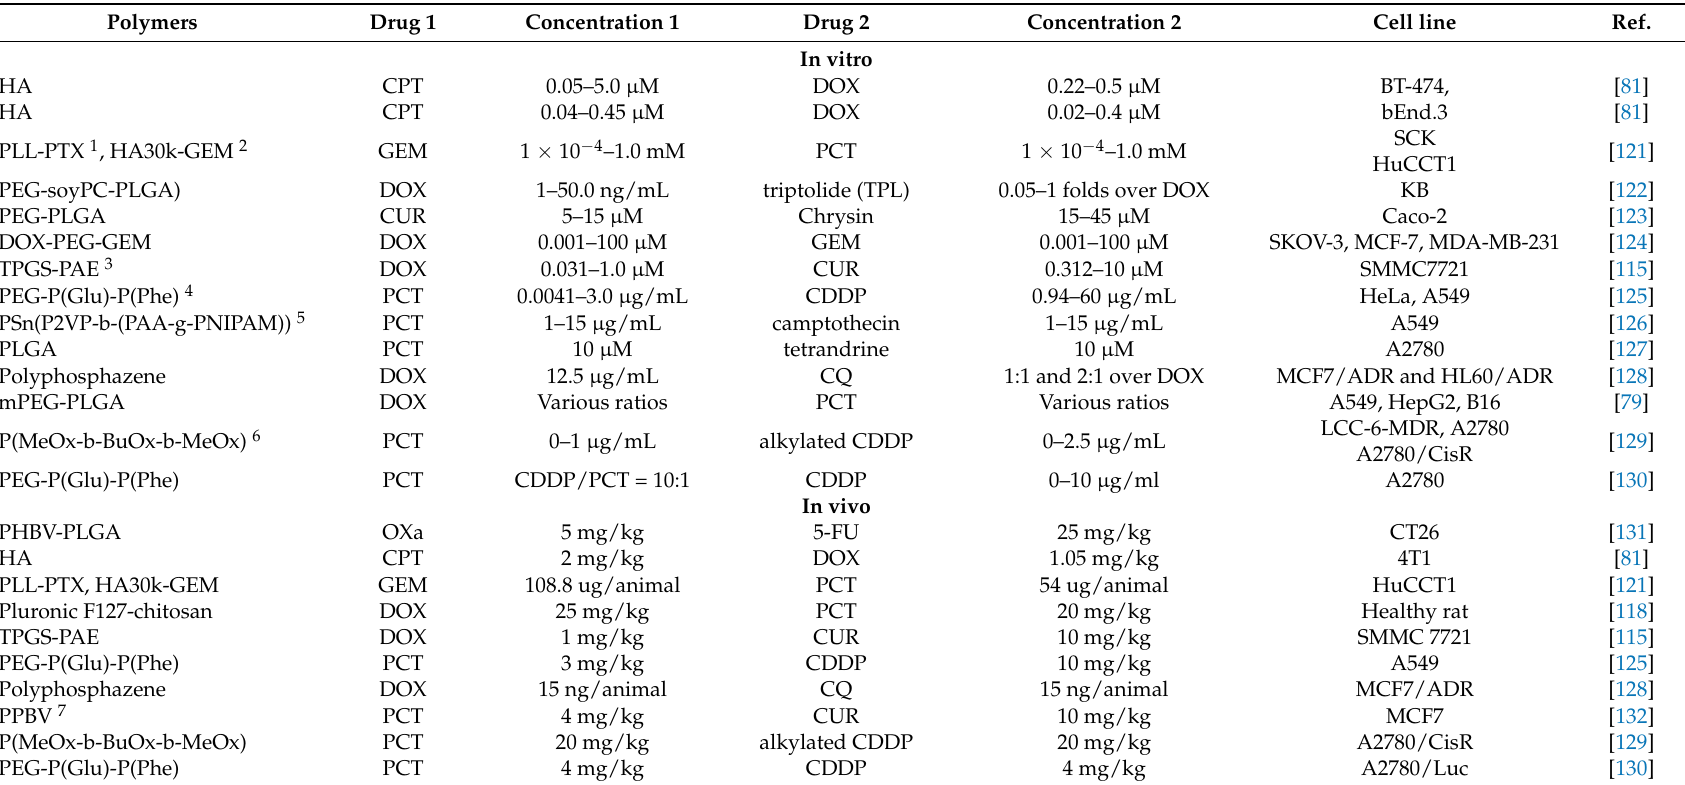
Table 2. Combinations of chemotherapeutics delivered in polymeric co-delivery systems. Polymers Concentration